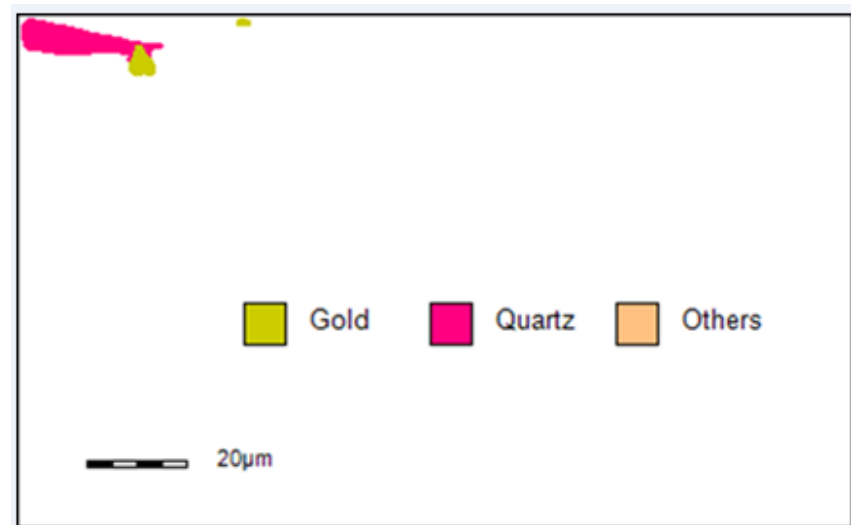
Figure 3. Particle map depicting observed occurrence of gold grains in the sample.